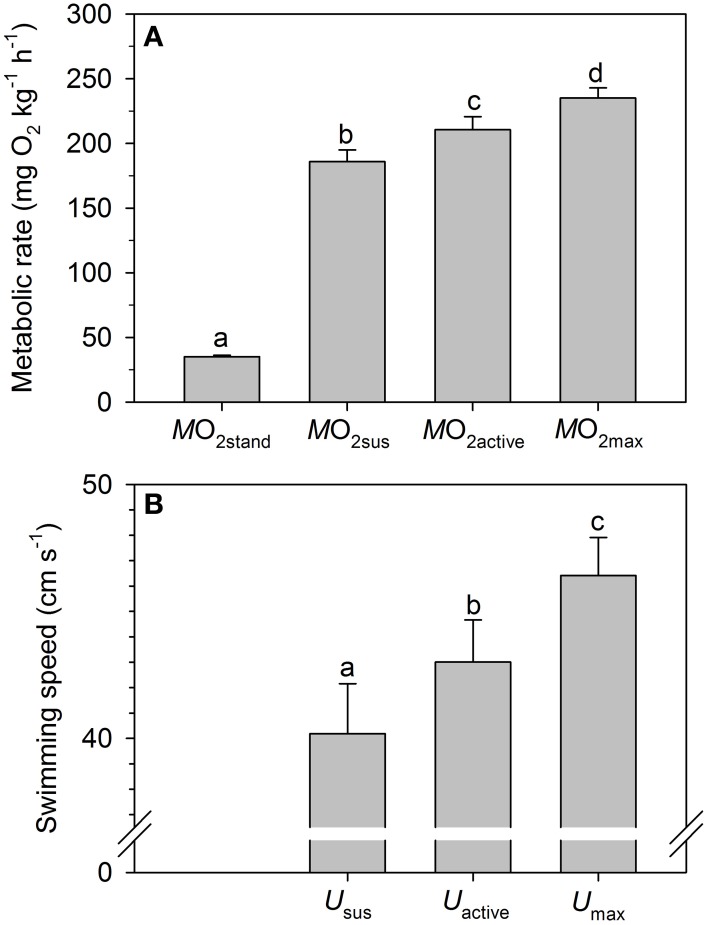
Measurements of (A) metabolic rate (mg O2 kg−1 h−1) and (B) swimming speed (cm s−1) in gilthead sea bream (Sparus aurata). Data include standard metabolic rate (MO2stand), maximum sustained (or aerobic) metabolic rate (MO2sus), active metabolic rate (MO2active) and maximum metabolic rate (MO2max). The measurements are defined in detail in the text. Corresponding swimming speeds (B) were derived from the metabolic measurements and include maximum sustained (Usus), active (Uactive) and maximum (Umax) swimming speeds. There are significant differences (P < 0.05) between the measurements of metabolism and swimming speed as indicated by the different letters.